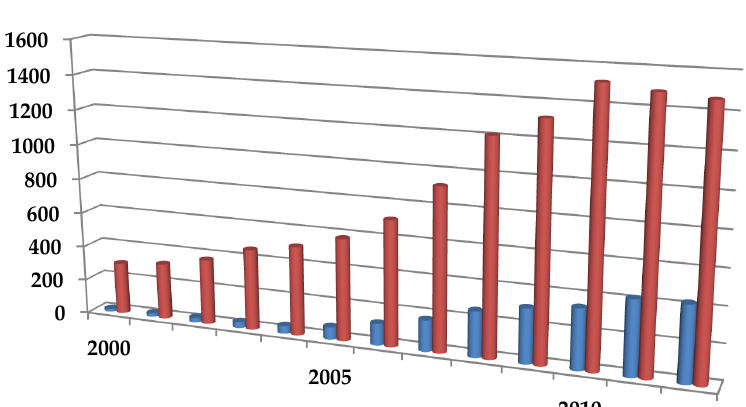
Figure 1. Global biofuel production by fuel type (thousand barrels per day). Data adapted from [9].